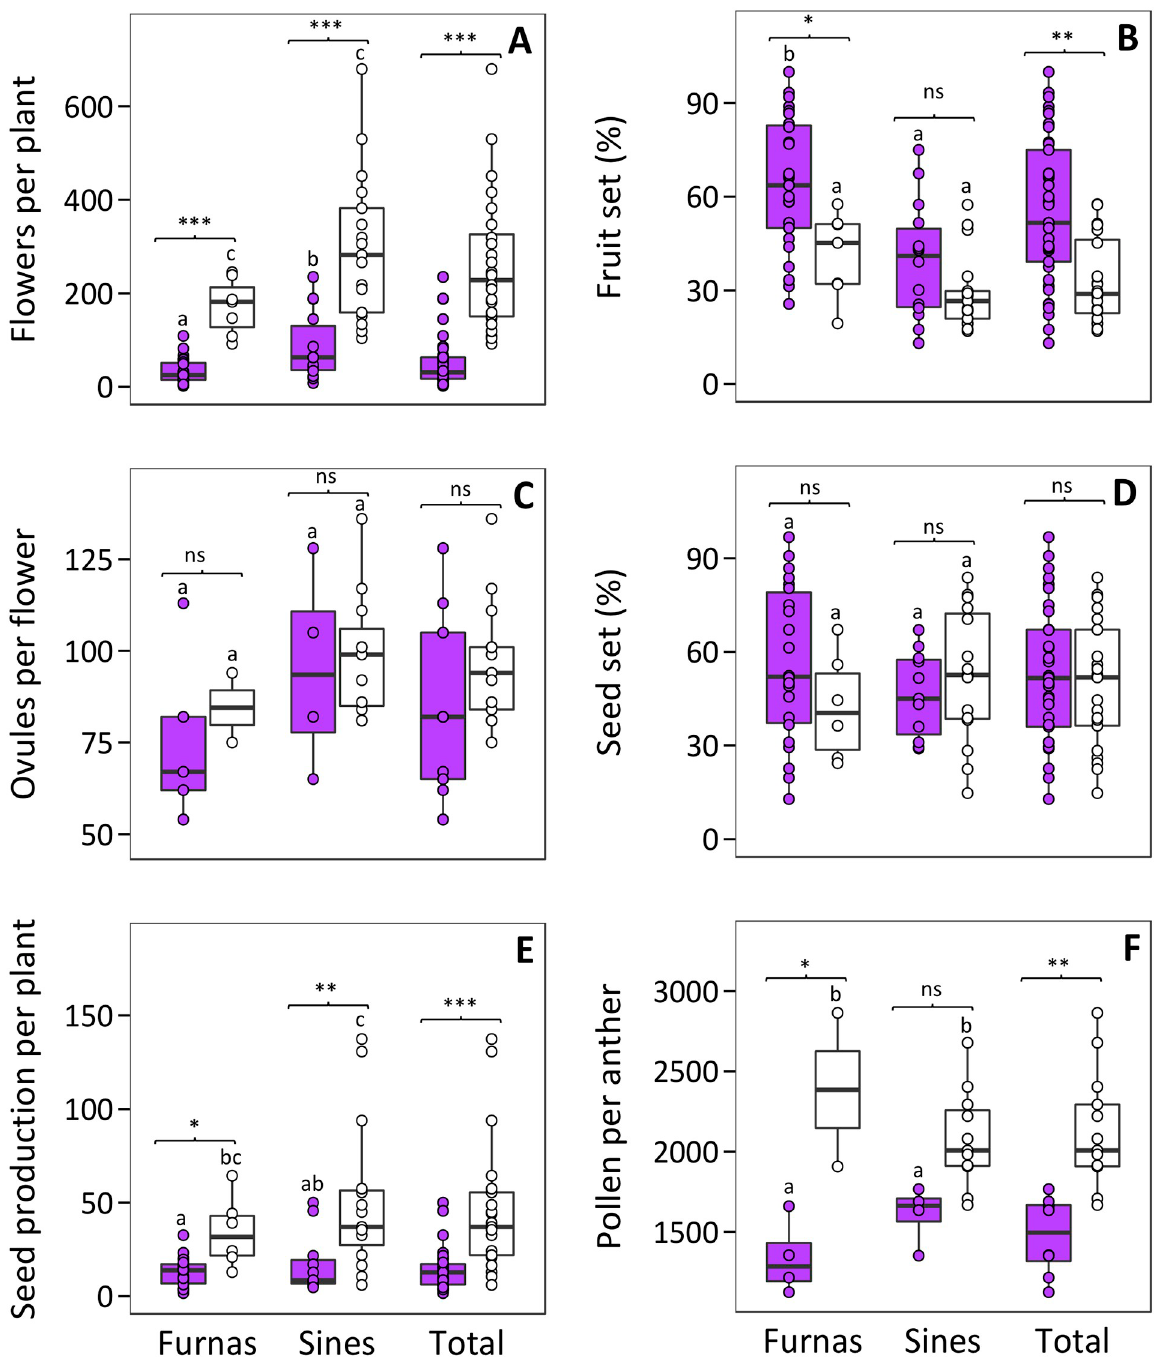
Fig 4. Boxplots representing the total flowers per plant (A), fruit set (B), ovules per flower (C), seed set (D), seed production per plant (E) and pollen per anther (F) in plants growing in the UV-present (purple boxes) and UV-exclusion (white boxes) treatments. Points represent values for all estimations of plant reproductive performance. The central line displays the median, the bottom and top of the box are the first and third quartiles, and point represent sample values. Lowercase letters are used to show statistical results of multiple comparisons between populations. Within each population, pairwise comparisons between light treatments using Bonferroni adjustment are shown. ns, not significant; � , P < 0.05; �� , P < 0.01; ��� , P < 0.001.